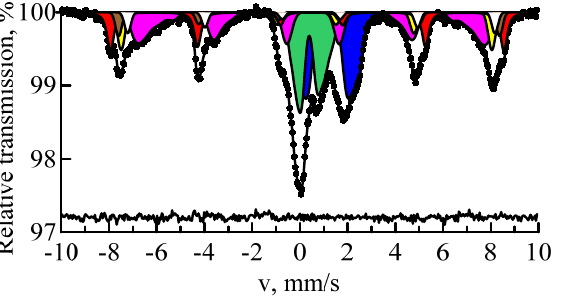
Figure 3. MS spectrum of 57 Fe nuclei in the sample of fly ash FA2: hematite (red); maghemite (brown and white); magnetite (yellow and magenta) and the paramagnetic minerals (blue and green). Table 2. Hyperfine parameters of the magnetic fraction obtained from the MS spectrum of the fly ash FA2.